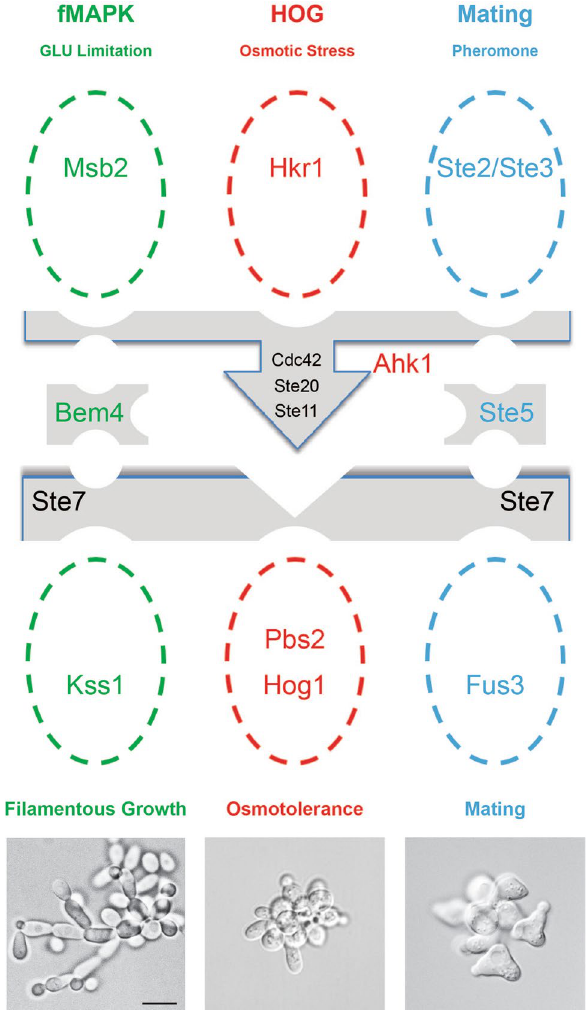
Figure 1. Three MAPK pathways in yeast share a subset of common components. Common components are shown in black, and pathway specific proteins are shown in color for the fMAPK (red), HOG (green), and mating (blue) pathways. Each pathway has a scaffold-type adaptor, Bem4 70 , Pbs2 45 and Ahk1 71 , and Ste5 52 , and a specific MAP kinase. Cells undergo filamentous growth under nutrient-limiting conditions (left), cells do not change their morphology when exposed to YEP-GAL + 1.0 M KCl salt (middle), and YEP-GAL + 1 mg/ml α-factor stimulates an elongated cell shape or shmoo (right). Scale bar, 10